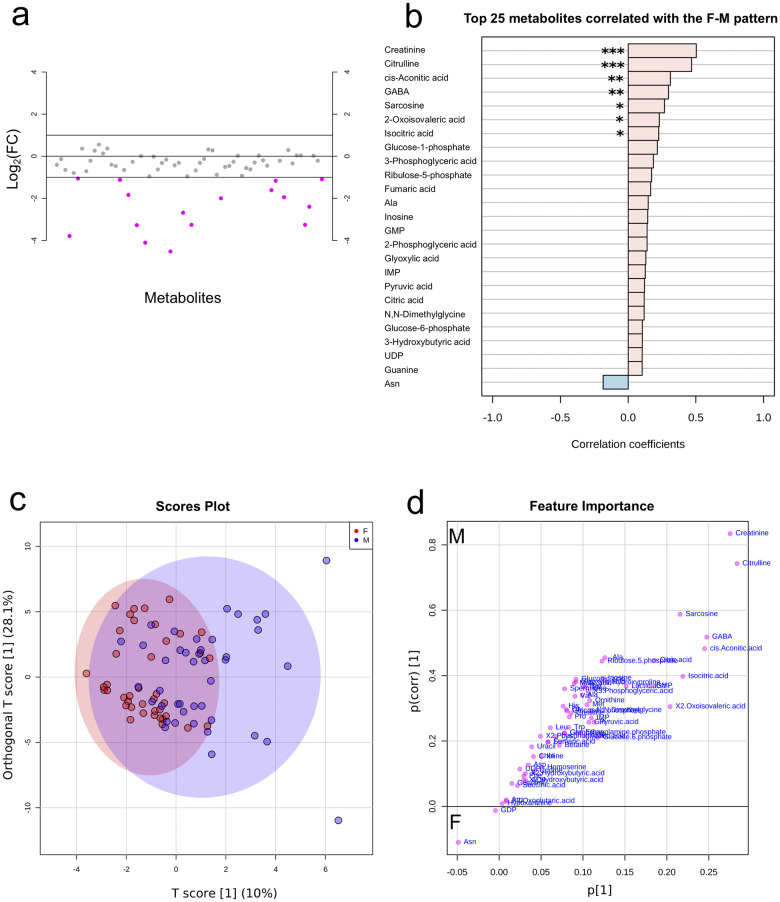
Metabolite profiles by sex.a) Metabolites identified by fold change (FC) analysis of female/male ratio with threshold of 2-FC. Values are on a log scale to show both up-regulated and down-regulated metabolites symmetrically. The plot shows metabolites that are up-regulated (positive-log scale) or down-regulated (negative log-scale). Pink symbols represent metabolites above the 2-FC threshold. b) Pattern correlation analysis showing metabolites (based on p-values) with different patterns between female and male (unadjusted top 7 metabolites significant; ***, p <0.001; **, p <0.01; *, p <0.05). Creatinine (FDR <0.001) and citrulline (FDR <0.001) remained significant after FDR correction. c) Score plot and d) Coefficient S-plot based on OPLSDA model of metabolite distribution according to sex (Y variable). Metabolites that significantly influenced the model (absolute p(corr) >0.5 and VIP ≥1.5) were creatinine, citrulline, sarcosine and GABA. For the S-plot, the y-axis represents the correlation or reliability coefficient and the x–axis represents the covariance or contributions of each metabolite to the model with respect to sex. GABA, gamma-aminobutyric acid; Ala, alanine; GMP, guanosine monophosphate; IMP, inosine monophosphate; UDP, uridine diphosphate; Asn, asparagine; F, female (n = 41); M, male (n = 42).